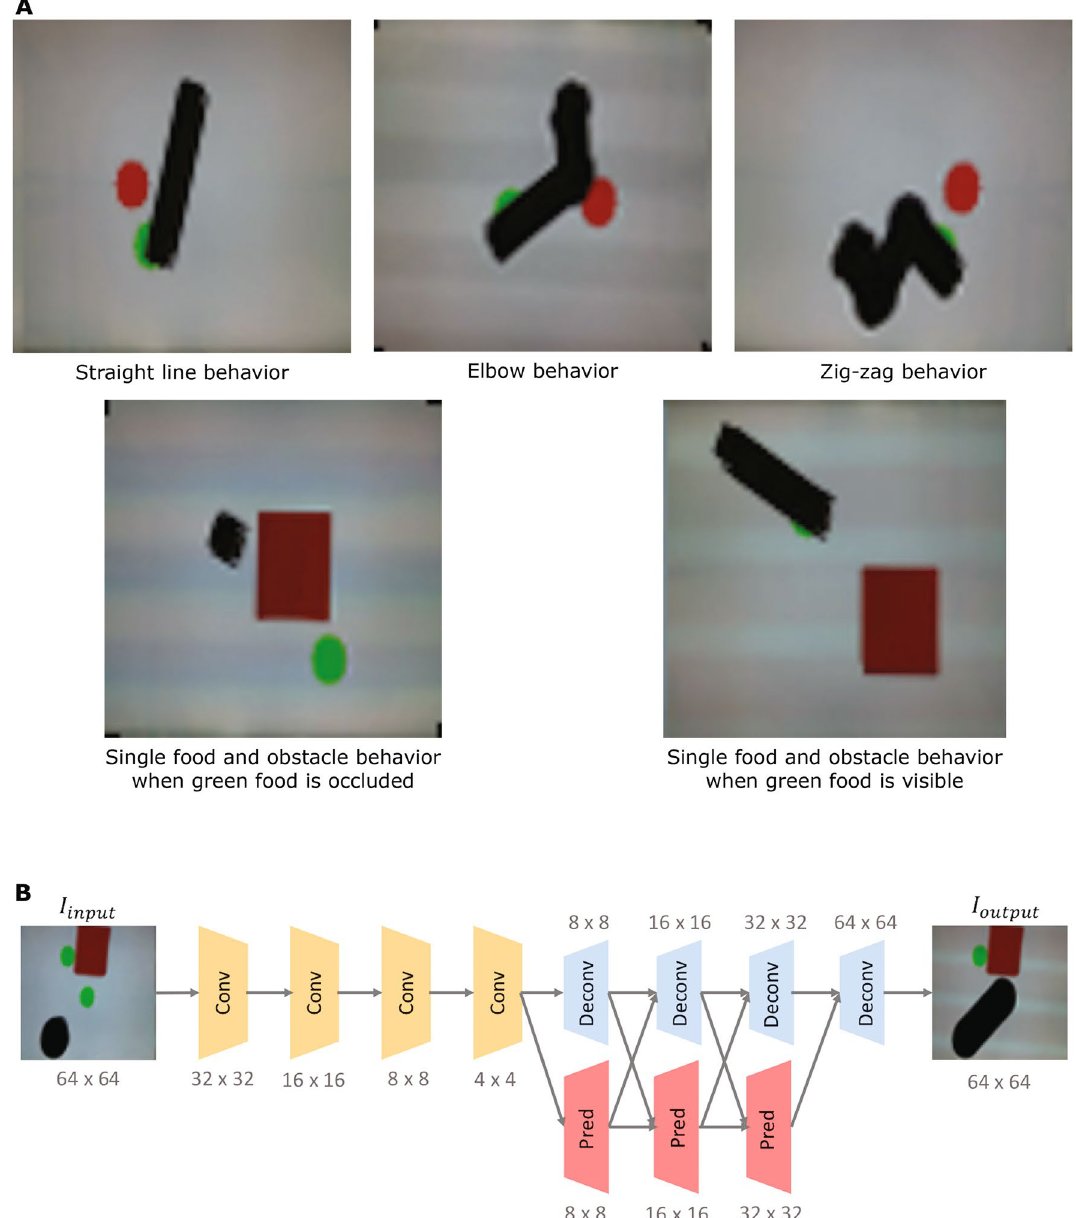
Figure 3. Visualization of the behaviors of the actor robots and Observer network architecture ( A ) We pre- programmed four types of behaviors for the actor robot. The images shown here are produced by integrating a sequence of frames from a video captured by the top-down camera. The robot path is shown in black, the rectangular obstacle (if any) in red and the goal circles in green or red. ( B ) The image prediction network is composed of several layers of convolutional units and deconvolutional units. At the deconvolutional stage, we utilize multi-scale prediction to maintain high resolution at the output image. Numbers indicate the dimension of output feature map after each